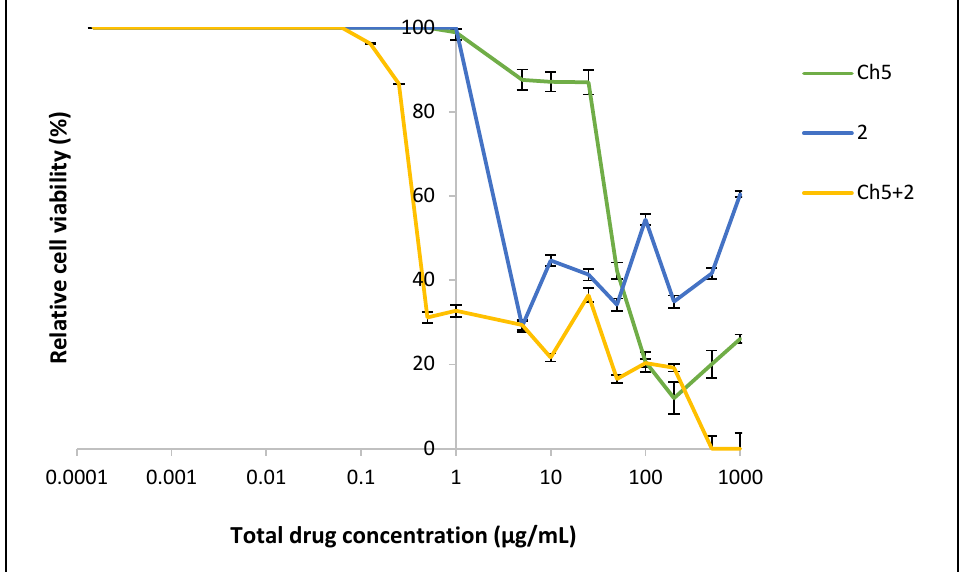
Figure 6. The viability of BxPC-3 cells after exposure to the polymer ( Ch5 ), 2 (drug) and encapsulated drug ( Ch5 + 2 ) for 24 h ( n = 6, ±SD).